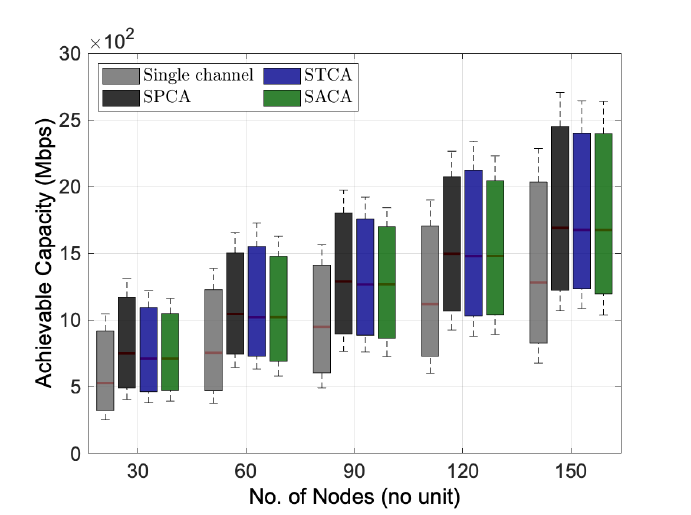
Figure 6. Performance comparison between different fixed channel allocation schemes for the distribution of achievable capacity versus the number of